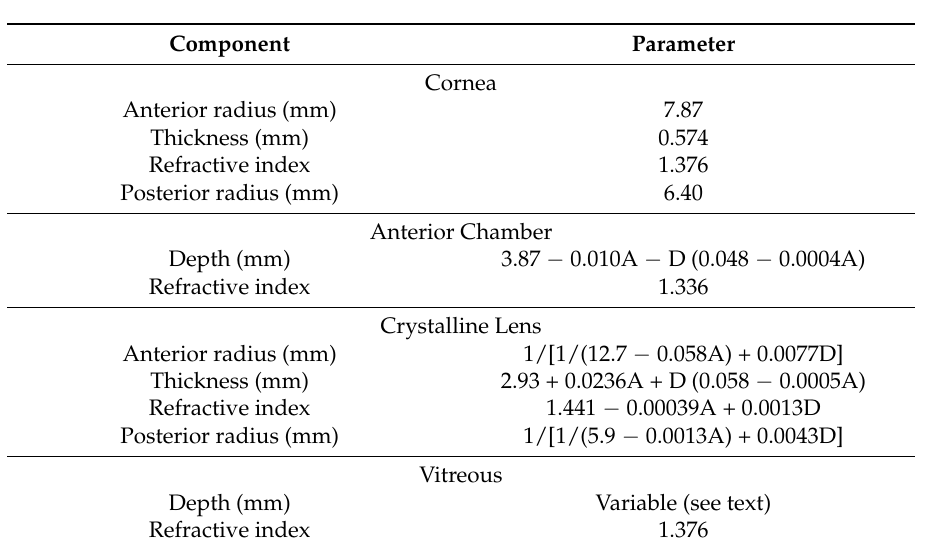
Table 1. The Dubbelman eye model [65]. Component radii, axial thicknesses, and refractive indices are shown. The equations shown refer to the dependence of various components on years of age (A) and dioptres of accommodative demand